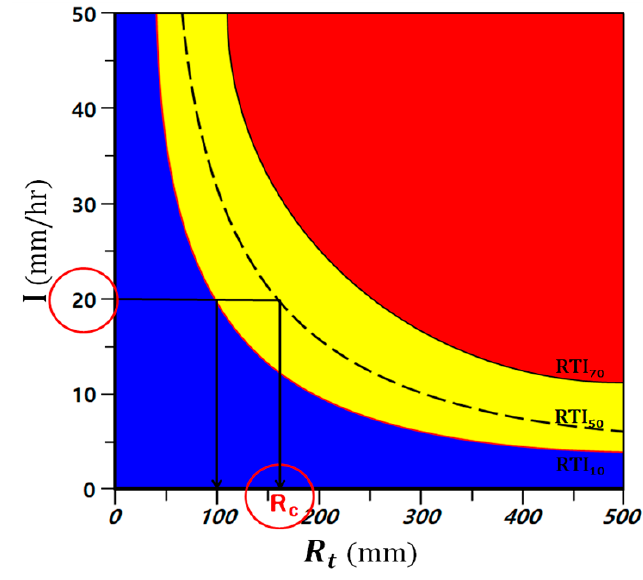
Figure 4. Concept of RTI and 𝑅 𝑐 [22].